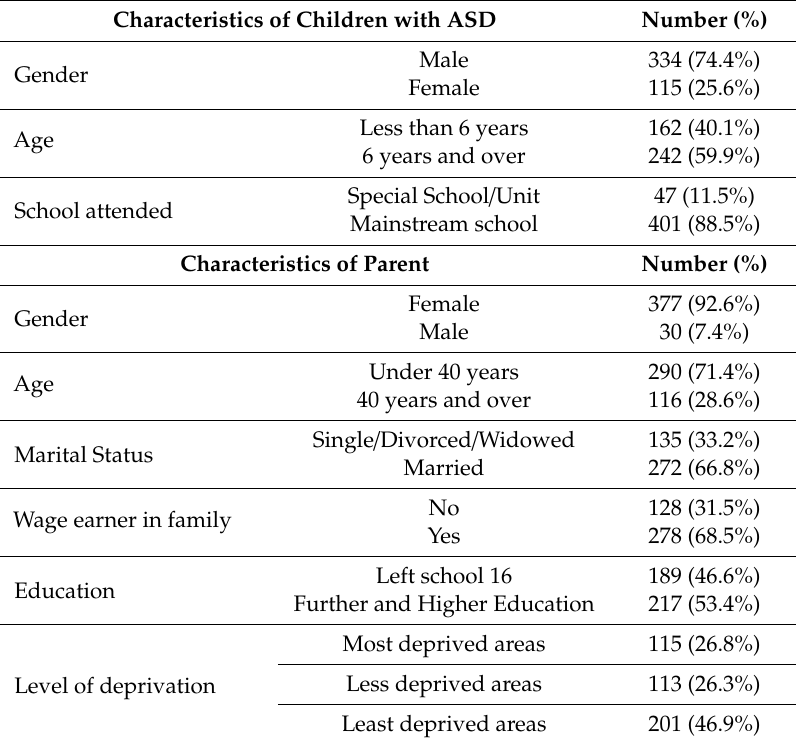
Table 1. The characteristics of the participants.